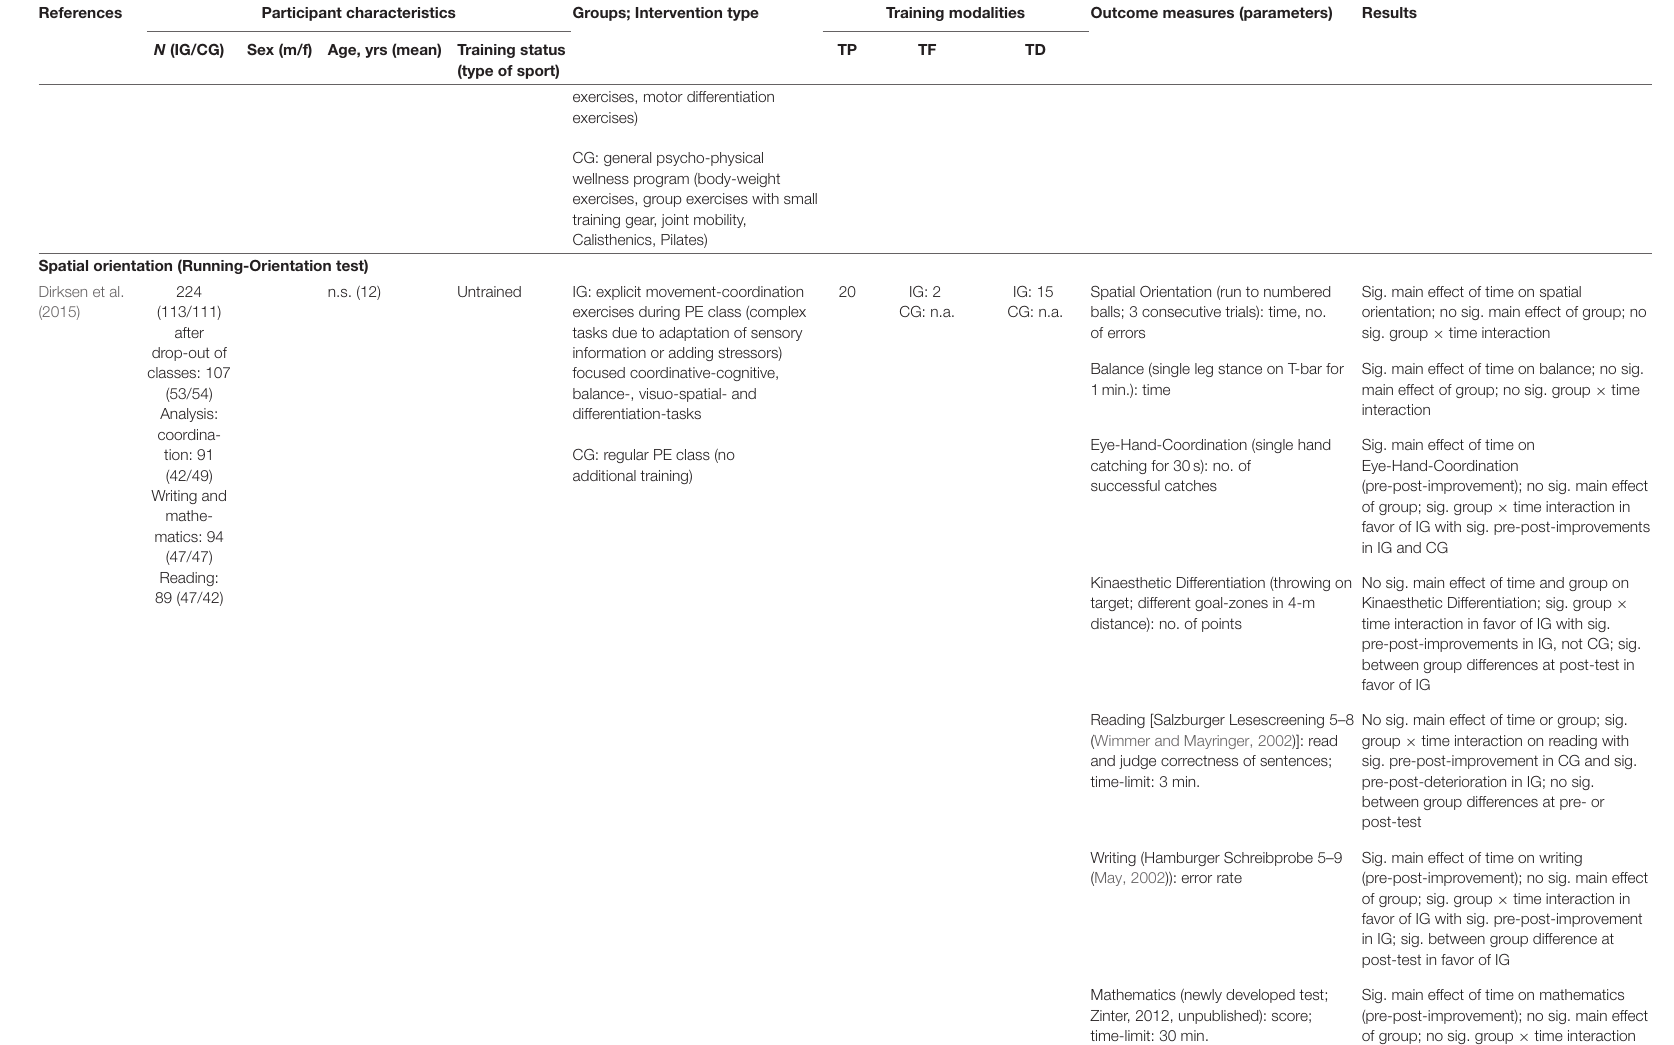
Groups; Intervention type Training modalities Outcome measures (parameters)